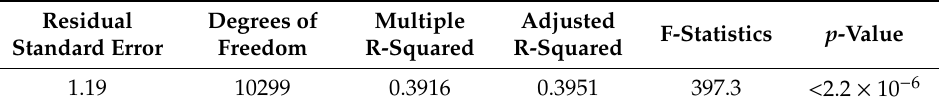
Table 4. Regression statistics summary.